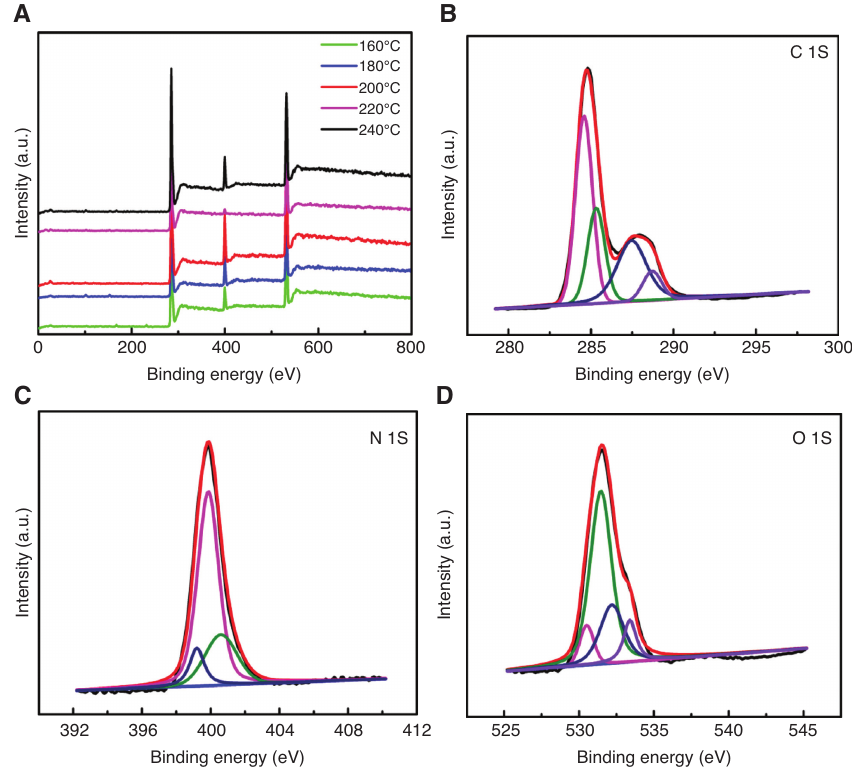
Figure 1: The NGQDs in Figure 1A are prepared in different temperatures. (A) Full-scan XPS spectrum of NGQDs and the high resolution of (B) C 1s, (C) N 1s, and (D) O 1s XPS spectrum of NGQDs (200 °